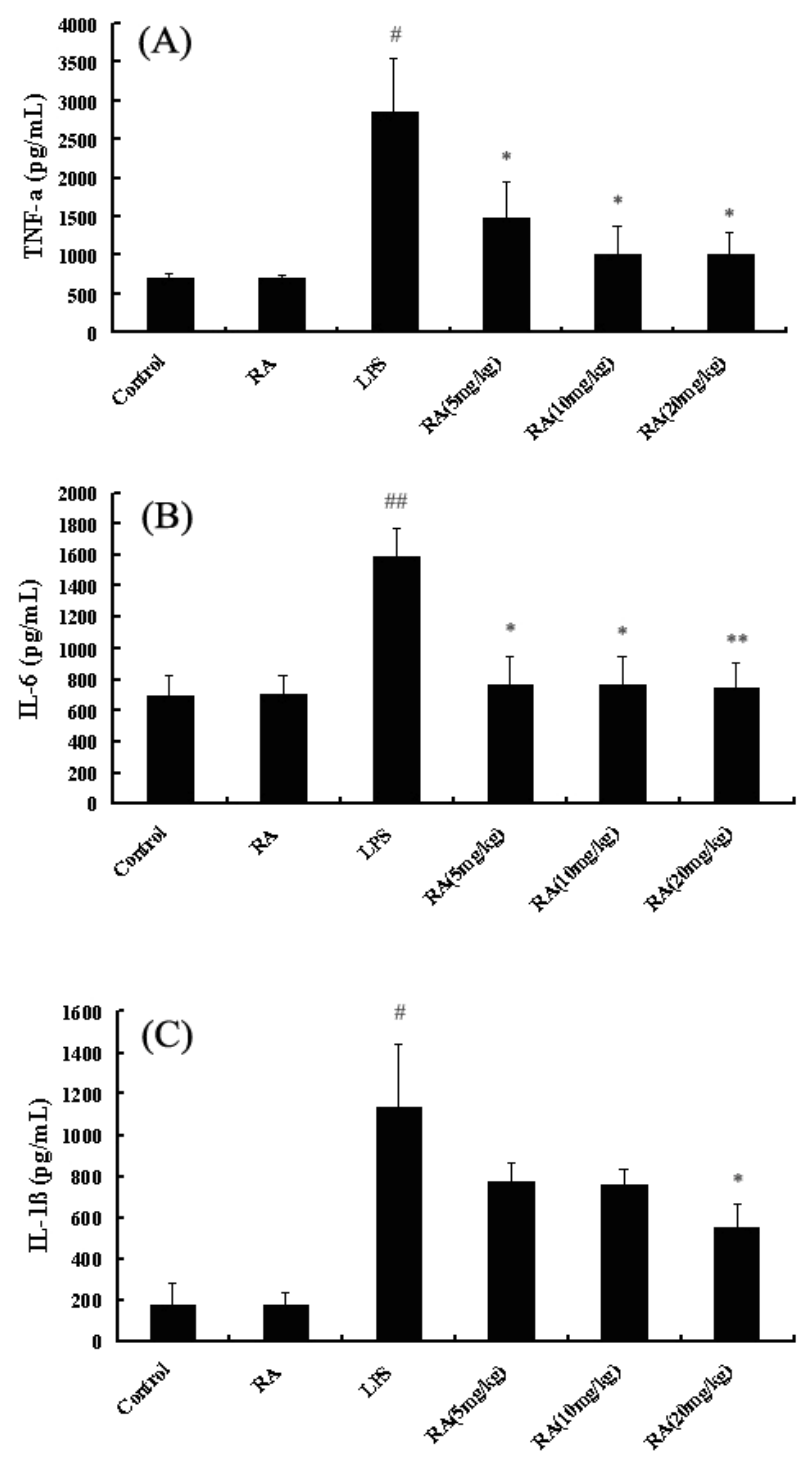
Figure 1. Effects of RA on TNF- α , IL-6, and IL-1 β expression from mice with ALI. Mice were given RA (5 mg/kg, 10 mg/kg, and 20 mg/kg) by intraperitoneal injected 1 h before challenge with LPS. BALF was collected at 24 h following LPS challenge to analyze